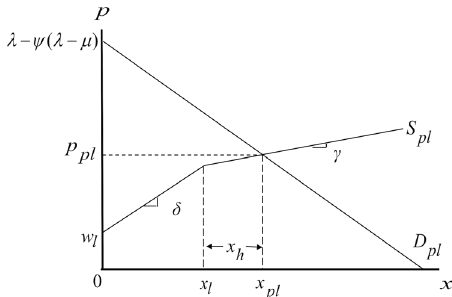
Fig. 4 Equilibrium conditions in Scenario II. This fi gure depicts the equilibrium conditions for Scenario II when the undifferentiated low-quality product coexists with its higher quality counterpart produced by less ef fi cient producers.